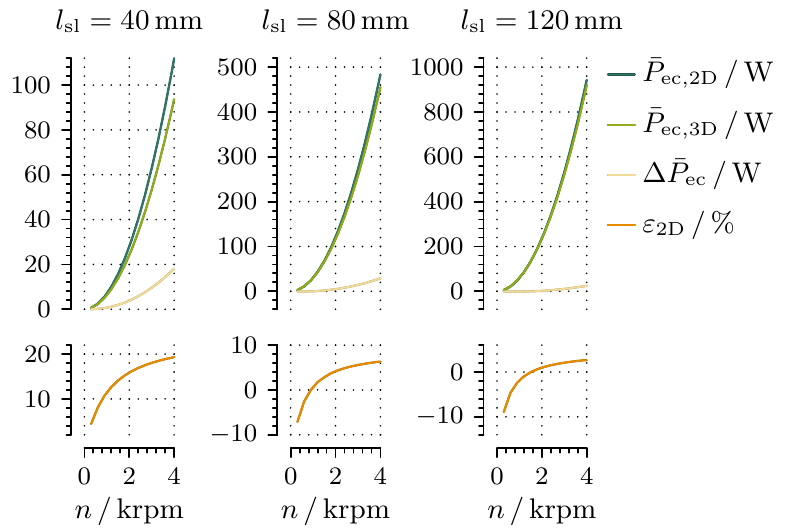
Figure 10. ¯ P ec,2D , ¯ P ec,3D , ∆ ¯ P ec , and ε 2D in the speed range from 300rpm to 4000rpm for l sl of 40mm, 80mm, and